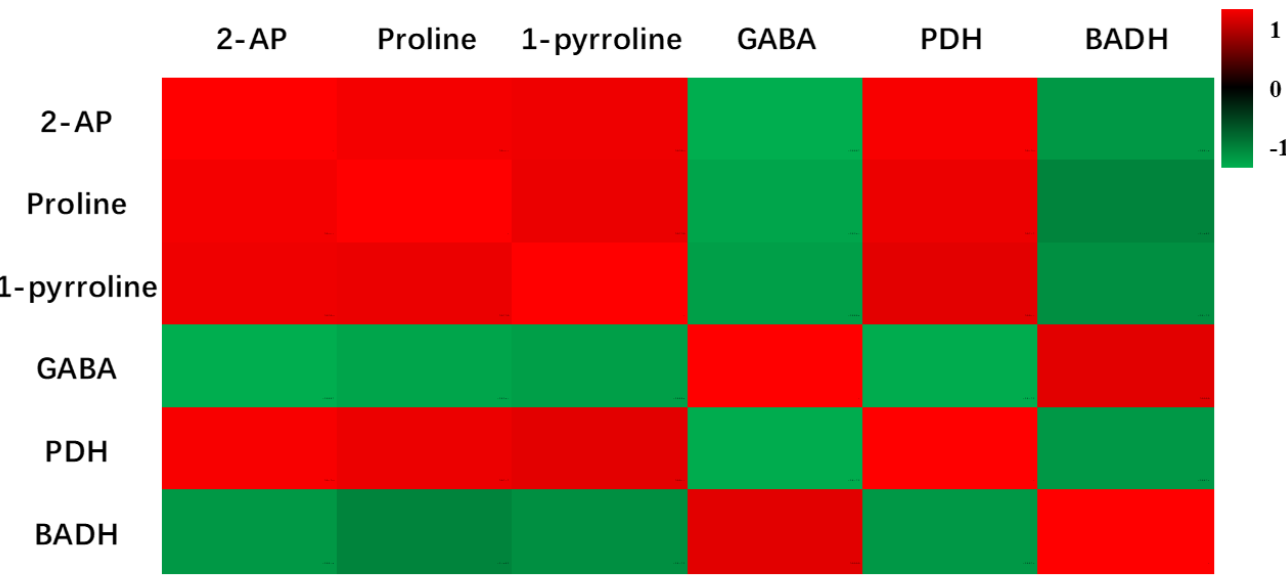
Figure 8. The heat map for 2-AP content, proline content, 1-pyrroline content, GABA content, PDH activity, and BADH activity.